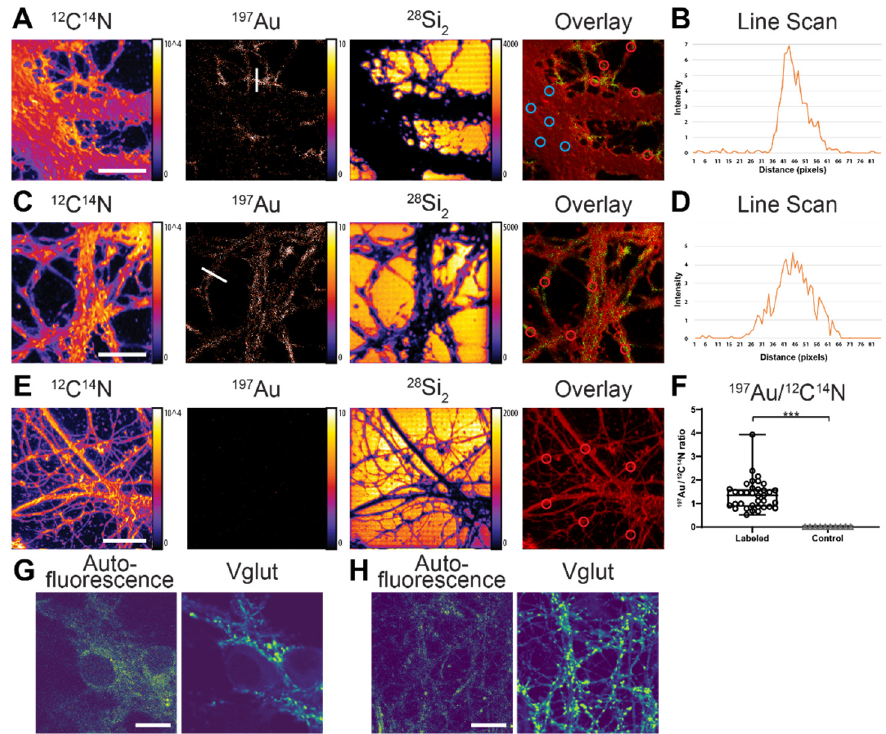
Figure 2. NanoSIMS imaging of vGlut protein in rat hippocampal neurons via direct immunolabeling with the Au anti-vGlut1 nanobody. ( A ) Cell body and neurites, 512 × 512 pixels. From left to right: ion images of 12 C 14 N, 197 Au, 28 Si 2 , and overlay of 197 Au (green) and 12 C 14 N (red). The blue circles in the overlaid image indicate the cell body while the red circles indicate the neurite areas. ( B ) A line-scan profile of 197 Au signal across a neurite in 197 Au image (white line). ( C ) Neurites, 512 × 512 pixels. From left to right: ion images of 12 C 14 N, 197 Au, 28 Si 2 , and overlay of 197 Au (green) and 12 C 14 N (red). The red circles in the overlaid image indicate the neurite areas. ( D ) A line-scan profile of 197 Au signal across a neurite in 197 Au image (white line). ( E ) Negative control cell without Au anti-vGlut1 nanobody. From left to right: ion images of 12 C 14 N, 197 Au, 28 Si 2 , and overlay of 197 Au (green) and 12 C 14 N (red). ( F ) Comparison of signal intensity of 197 Au between the cells labeled with the Au anti-vGlut1 nanobody and the negative control cells. Significantly higher signal in the labeled cells compared to the control cells verified by the Kolmogorov–Smirnov test (*** p < 0.0001). Each data point represents the average value of 197 Au/ 12 C 14 N ratio from all the pixels of individual ROIs ( n = 35 for labeled cells, n = 10 for control cells). Error bars show the SEM. Color scale of 197 Au image is scaled to the maximum intensities of respective 12 C 14 N image. ( G , H ) Exemplary confocal fluorescence images of vGlut1 in rat hippocampal neurons revealed by STAR580 conjugated anti-vGlut1 nanobodies ( n = 10 images). ( G ) vGlut1 localizes predominantly to the neurites, as compared with the cell body. ( H ) vGlut1 localizes to “hot spots” along the neurites. Scale bars are 10 µ